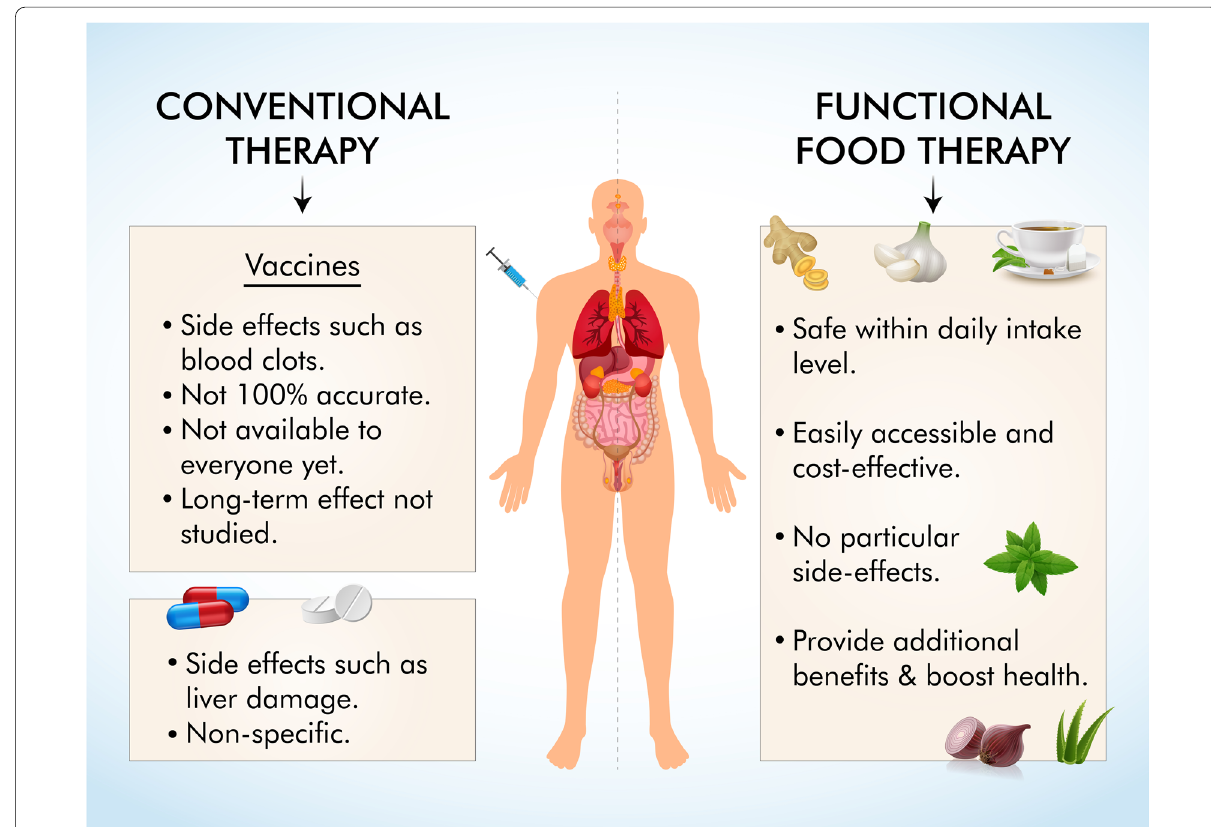
Fig. 2 Comparison of conventional COVID-19 therapies with functional food therapy. Vaccines and drugs, both part of conventional therapy, pose many challenges such as side effects, inaccessibility, non-specificity, and inaccuracy. In addition, the long-term accuracy and side effects of all COVID-19 vaccines have not been studied, making vaccine treatment very uncertain. In contrast, functional foods are simple, cost-effective food ingredients that are available to everyone. Furthermore, since daily intakes for these foods have been studied rigorously and established, they